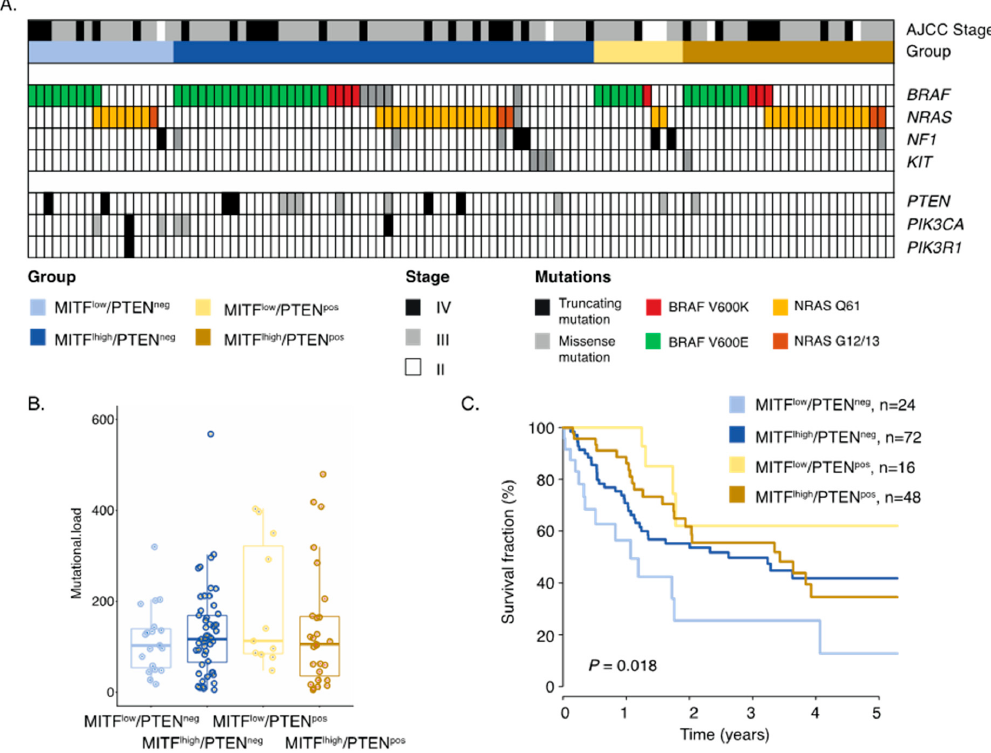
Figure 3. Molecular characterization of MITF/PTEN groups. ( A ) Mutational pattern of representative genes of the MAPK and PI3K pathways in MITF/PTEN groups. In MITF low /PTEN neg , two harbored PTEN mutation, three cases had PIK3CA mutation, and one had PIK3R1 mutation. In the MITF high /PTEN neg group, ten had PTEN mutation and one had PIK3CA mutation. The two other group had one PTEN mutated case each. ( B ) Mutational load across MITF/PTEN grouping using the number of mutations across 1500 cancer genes. p > 0.5, Kruskal–Wallis analysis. ( C ) Kaplan–Meier survival analysis using log-rank tests of MITF and PTEN markers combined. Survival data were missing for two cases in both MITF low /PTEN neg and MITF high /PTEN neg groups and five cases in the MITF high /PTEN pos group.